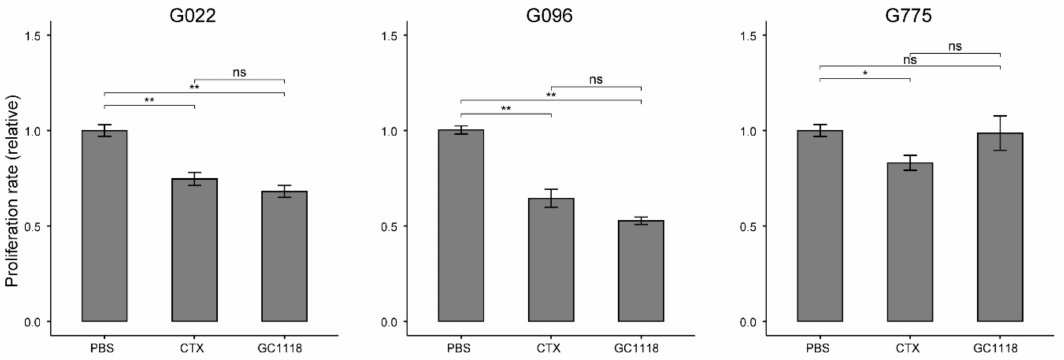
Figure 2. In vitro proliferation assay of glioblastoma patient-derived cells (PDCs). Three di ff erent PDCs were used to evaluate the anti-proliferative e ff ect of GC1118. Data are representative of five independent experiments and values are expressed in mean ± standard error p-values were calculated using two-sided Wilcoxon rank sum test (non-significant., p > 0.05; *, p ≤ 0.05; **, p ≤